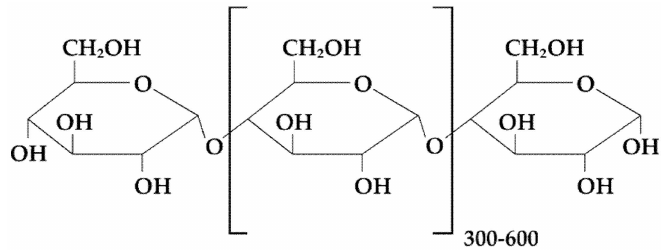
Figure 3. Schematic illustration of starch